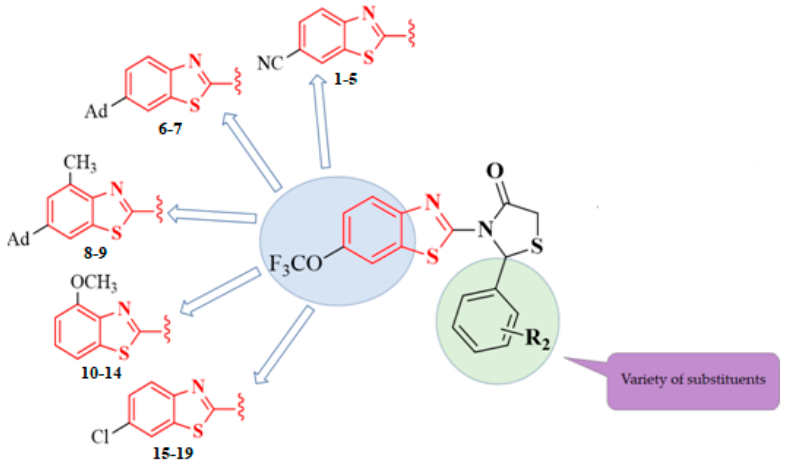
Figure 2. The structural modifications.